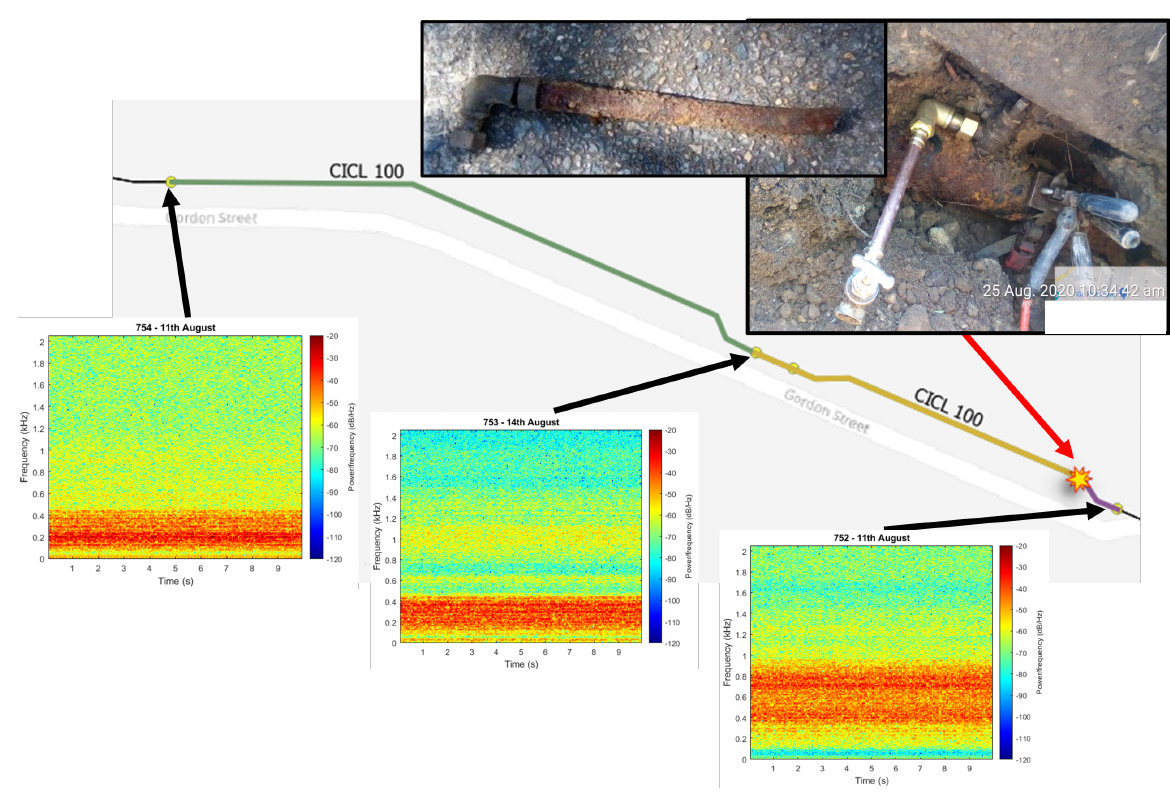
Figure 6. Leaking service line, detected by three individual HWM PCorr+ loggers at distances of 11 m (purple), 75 m (yellow) and 210 m (green) from the leak